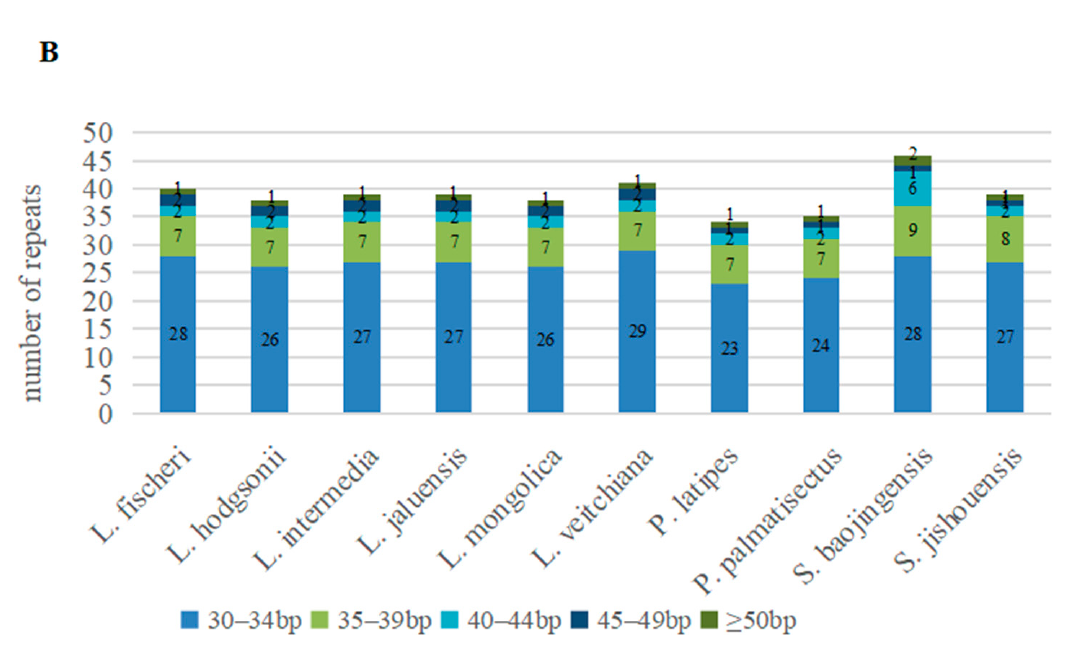
Figure 4. Analysis of interspersed repeat sequences in the cp genomes from 10 Senecioneae species. ( A ) The quantity of four types of repeats in different species. ( B ) The number of repeats with different lengths in different species.